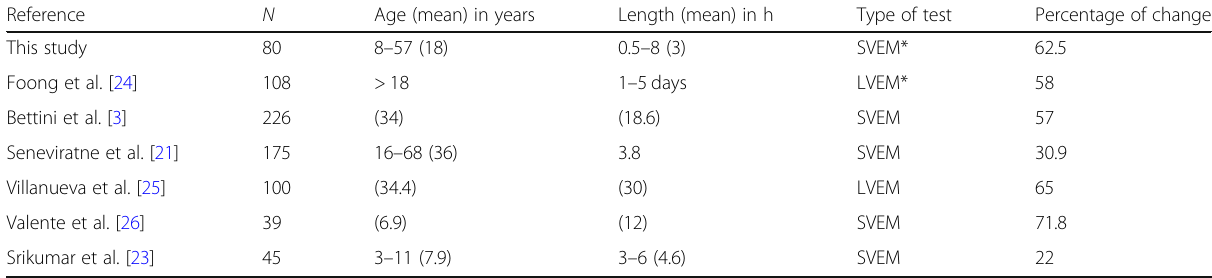
Table 5 Comparison of video EEG monitoring studies regarding the change of diagnosis Reference N